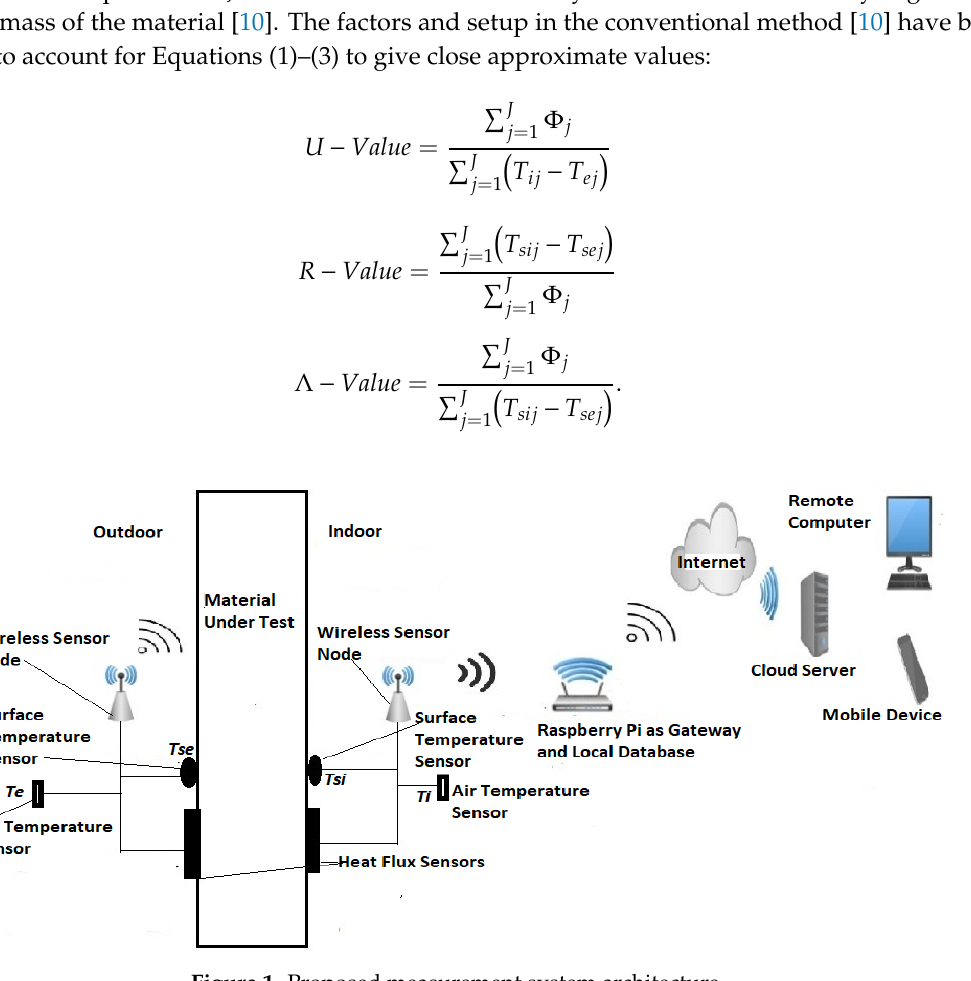
Figure 1. Proposed measurement system architecture.